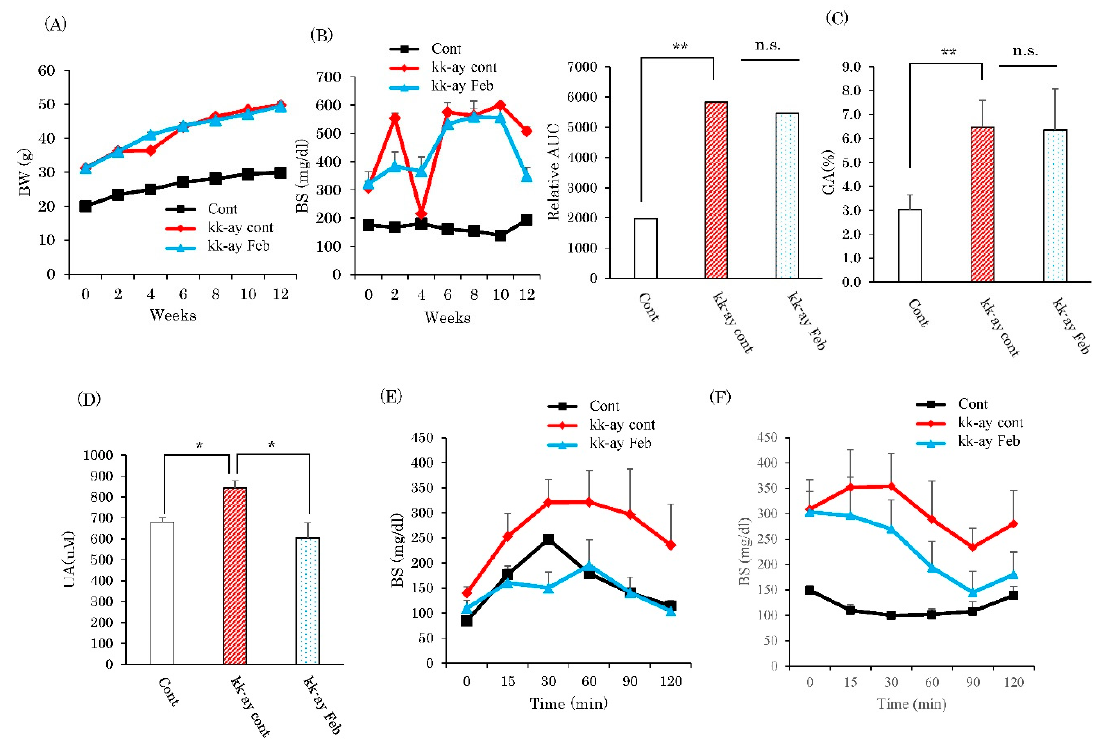
Figure 1. Inhibitory effects of xanthine oxidase inhibitor febuxostat on the progression of diabetic nephropathy. ( A ) Body weights and ( B ) blood sugar levels were measured. ( C ) Serum glycated albumin levels. ( D ) Serum uric acid levels. ( E ) Glucose tolerance test results. ( F ) Insulin tolerance test. Data are means ± SE. * p < 0.05, ** p < 0.001, n = 8 for control group, n = 10 for KK-Ay mice without febuxostat group and n = 8 for KK-Ay mice with febuxostat group.